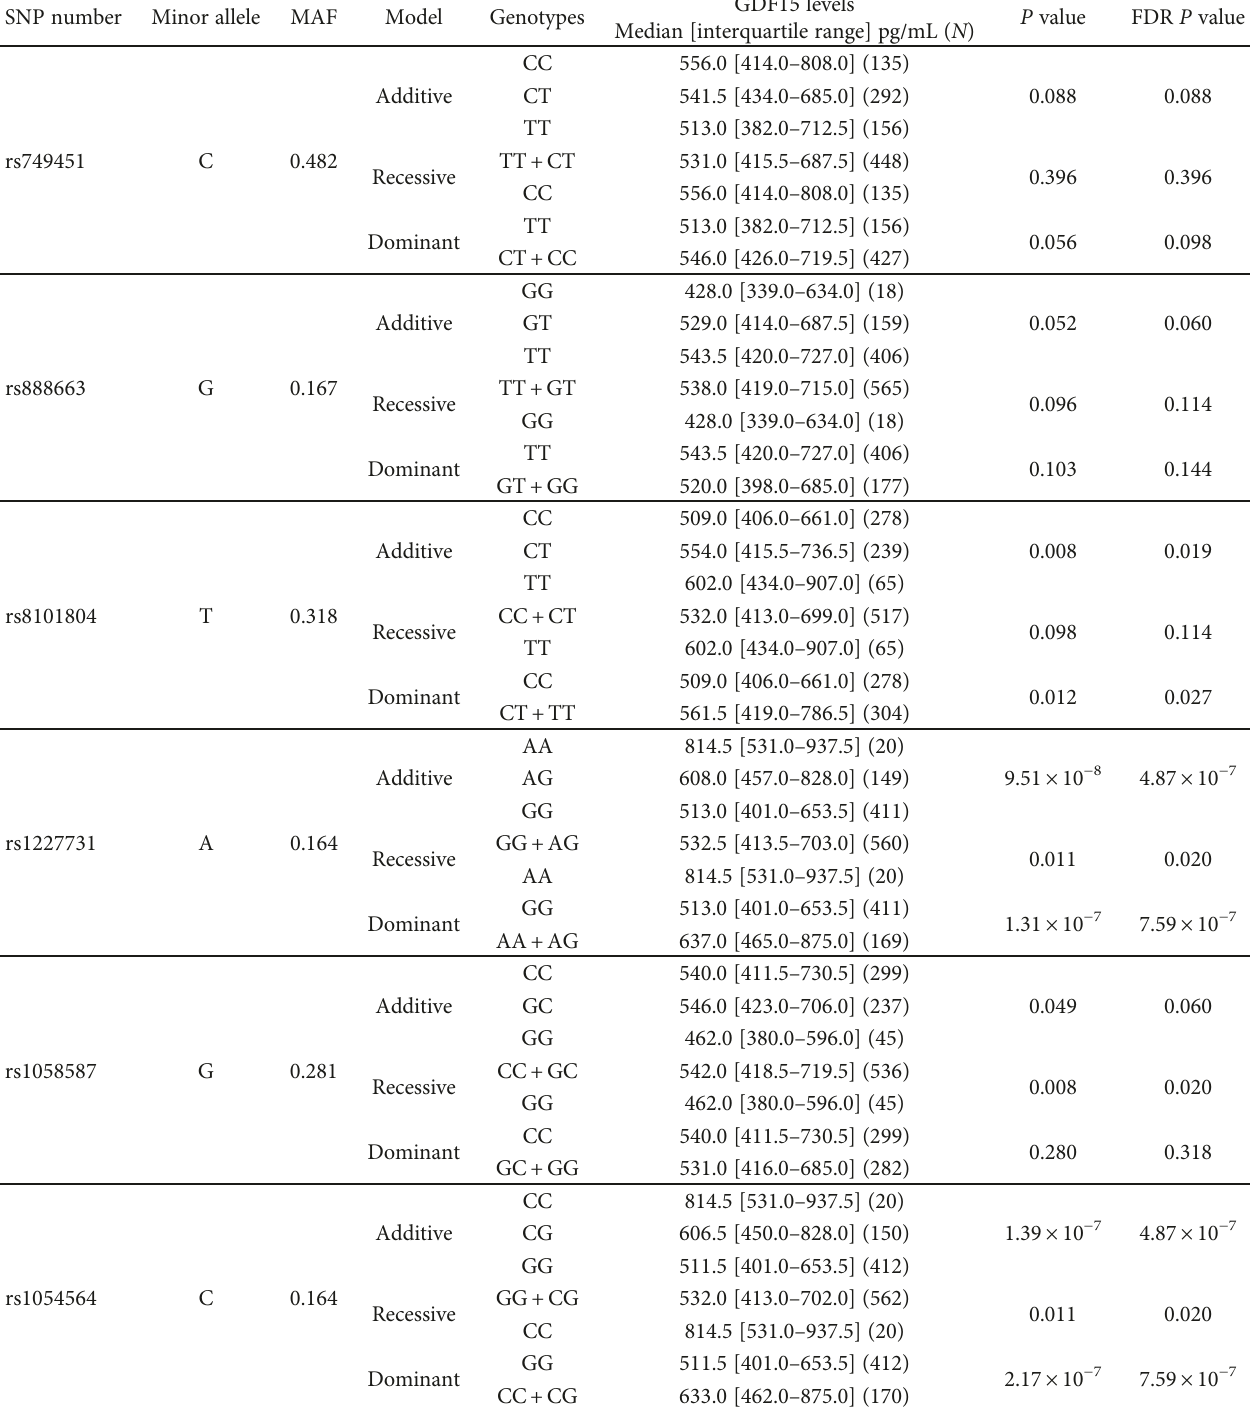
Table 2: Association of circulating growth di ff erentiation factor 15 ( GDF15 ) locus genotypes with GDF15 level in subjects from the healthy